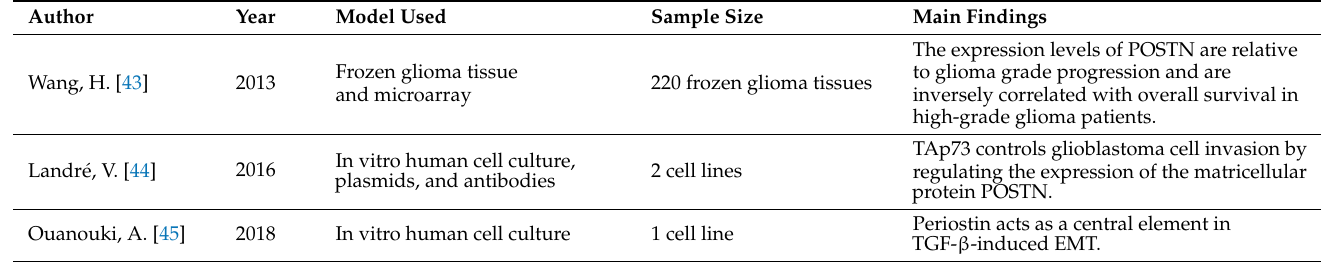
Table 3. Periostin.